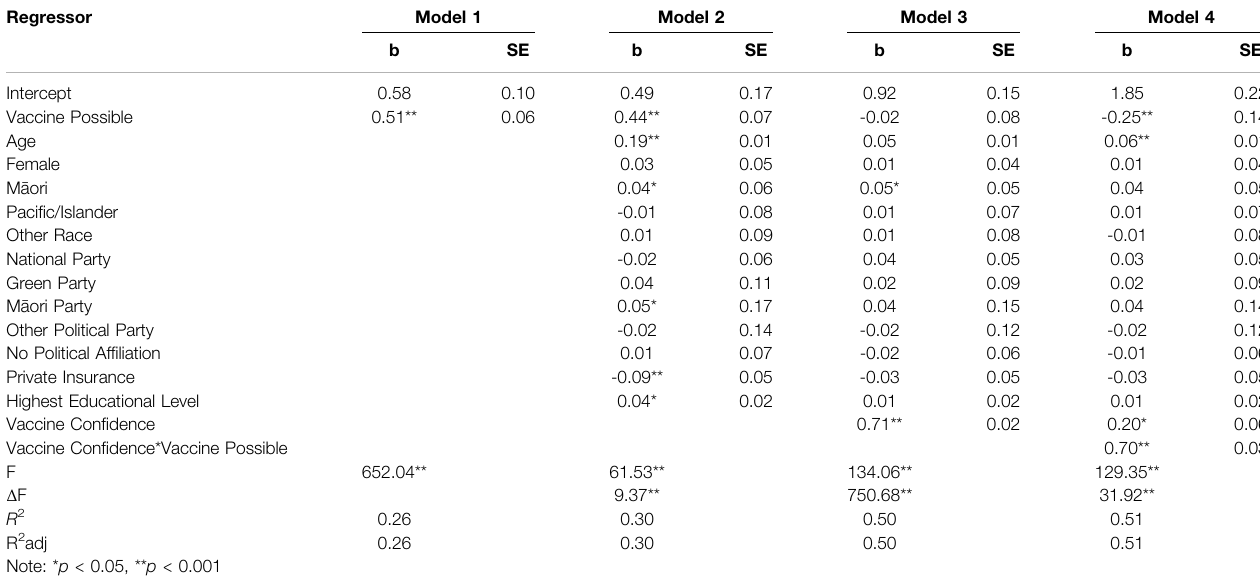
TABLE 2 | Regression Model for Support for employer Mandates.